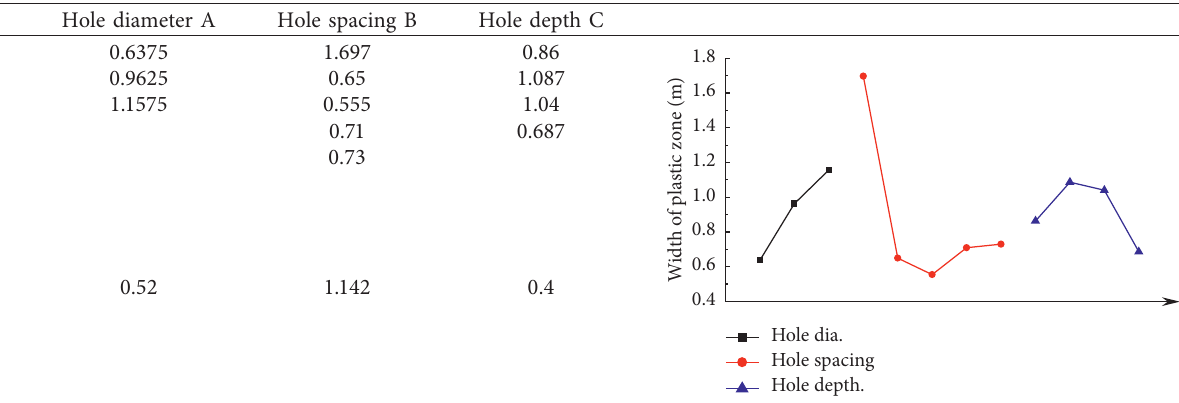
Table 9: Range for width of plastic zone Δ L of each model.